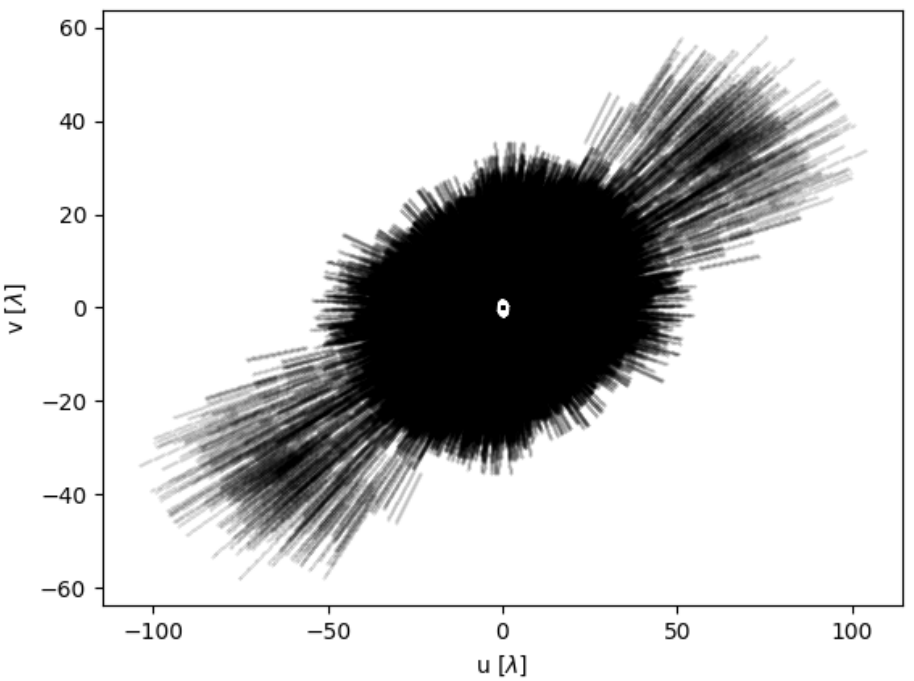
Figure 2. Chromatic uv -coverage of our NenuFAR observation, in units of central wavelength. The relevant frequencies are 29.8 MHz to 38.8 MHz. Note that the axes now extend to 100 λ . Note the extremely high point density in this plot: the high fractional bandwidth ensures a very com- plete coverage for all non-distant miniarrays, and even fill out the uv -gap between the core and distant